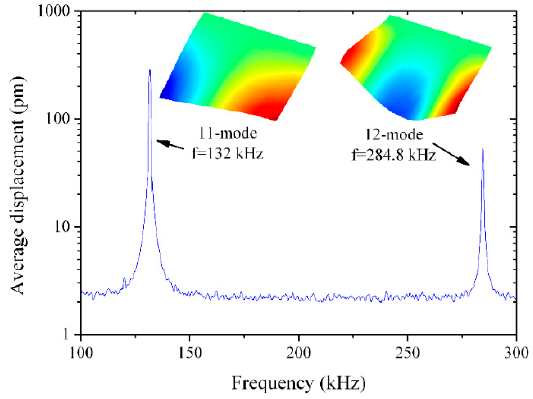
Figure 2. Measured frequency response of the cantilever from 100 to 300 kHz by means of a laser Doppler vibrometer. Modes (11) and (12) were detected. The measured modal shapes are also